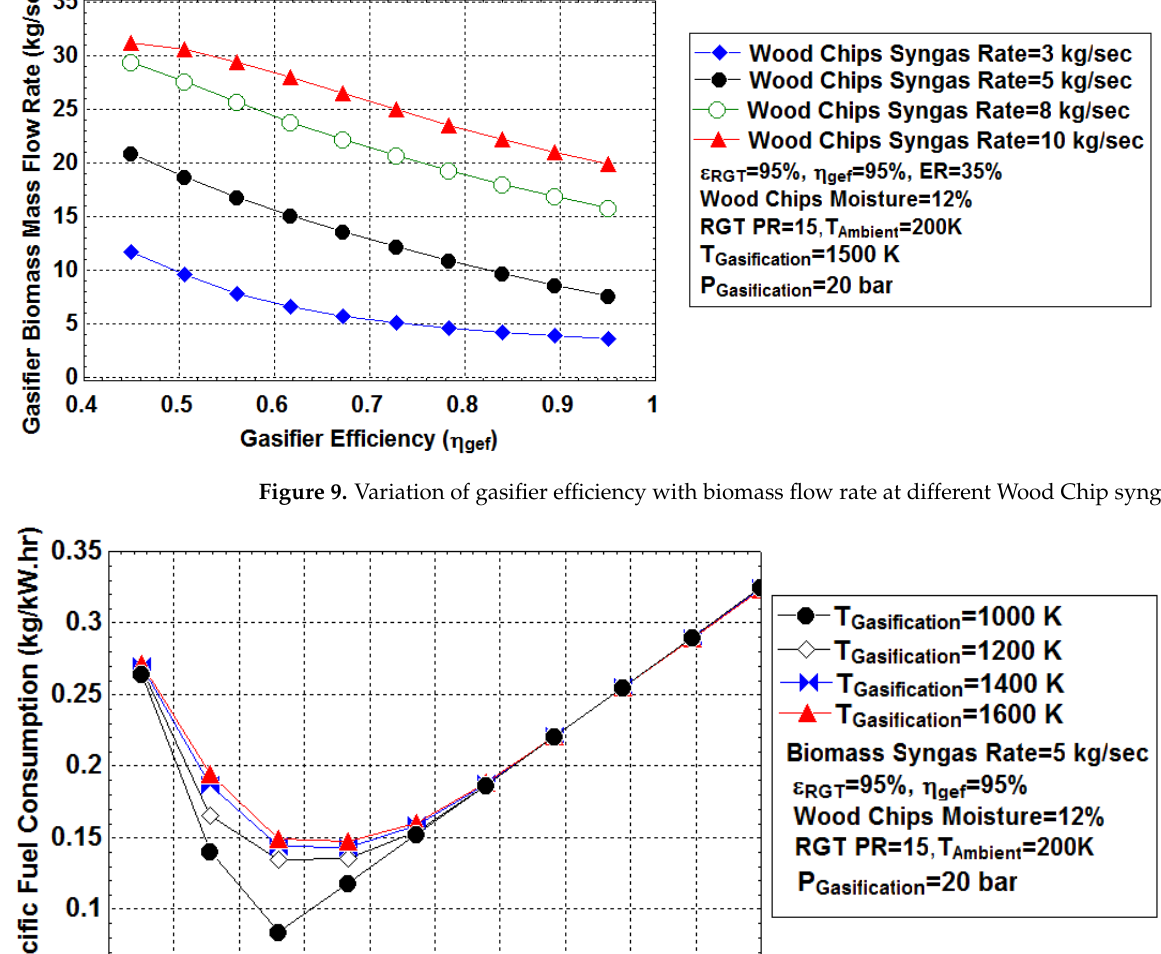
Figure 10. Variation of equivalence ratio with the specific fuel consumption at different gasification temperatures.